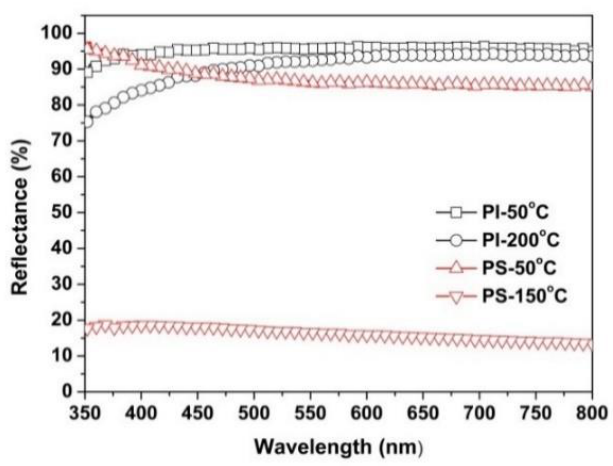
Figure 11. UV-Vis reflectance plots of PI-3 membranes after heat treatment.